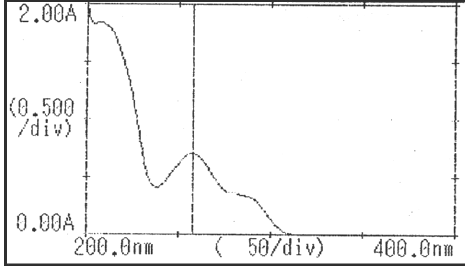
Figure 2. Zero order spectrum of itopride hydrochloride in water